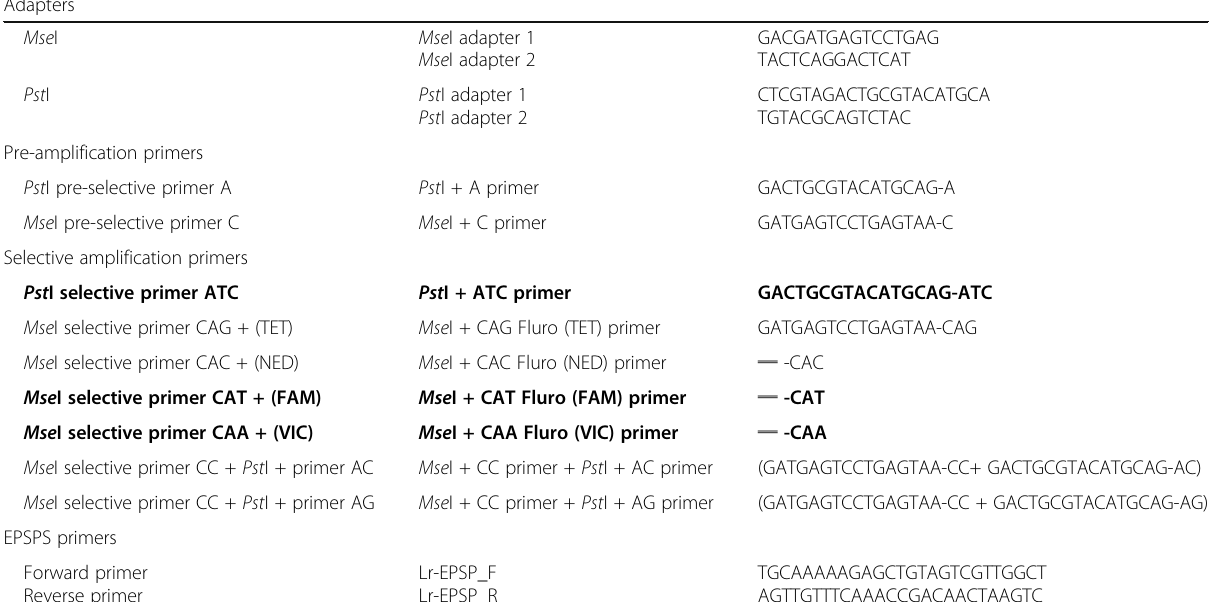
Table 2 Sequences (5 ′– 3 ′ ) of adapters and primers used in adjusted AFLP for the within and between population studies and sequences (5 ′– 3 ′ ) of primers used for the sequencing of the conserved region of EPSP. Data in boldface shows the most informative primers in terms of number of bands and